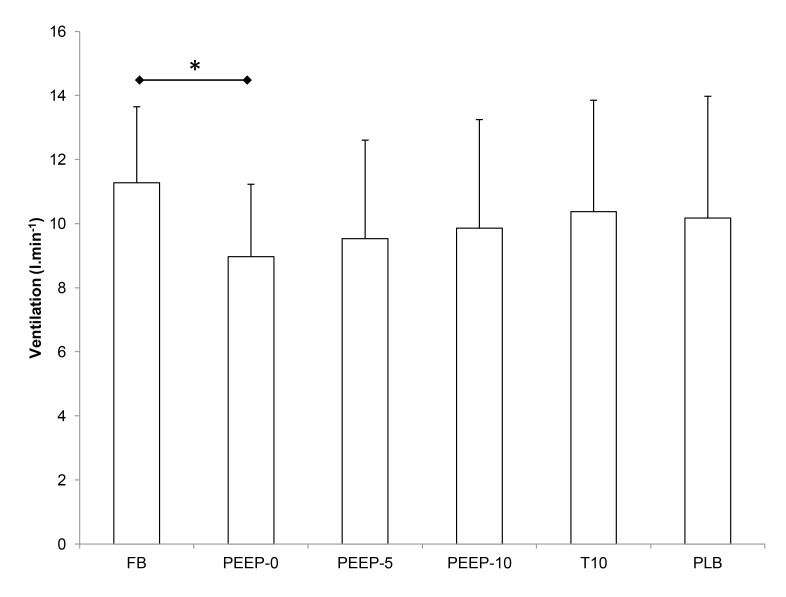
Minute ventilation in all experimental conditions.See Figure 1 for abbreviations. * significant difference between two conditions (p < 0.05).